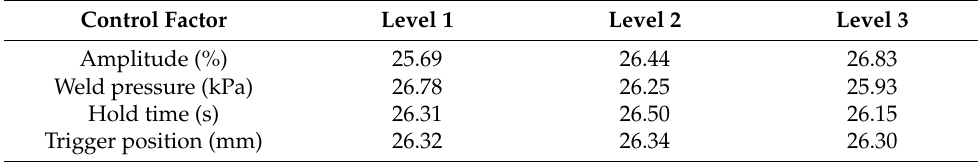
Table 2. Tensile testing results.